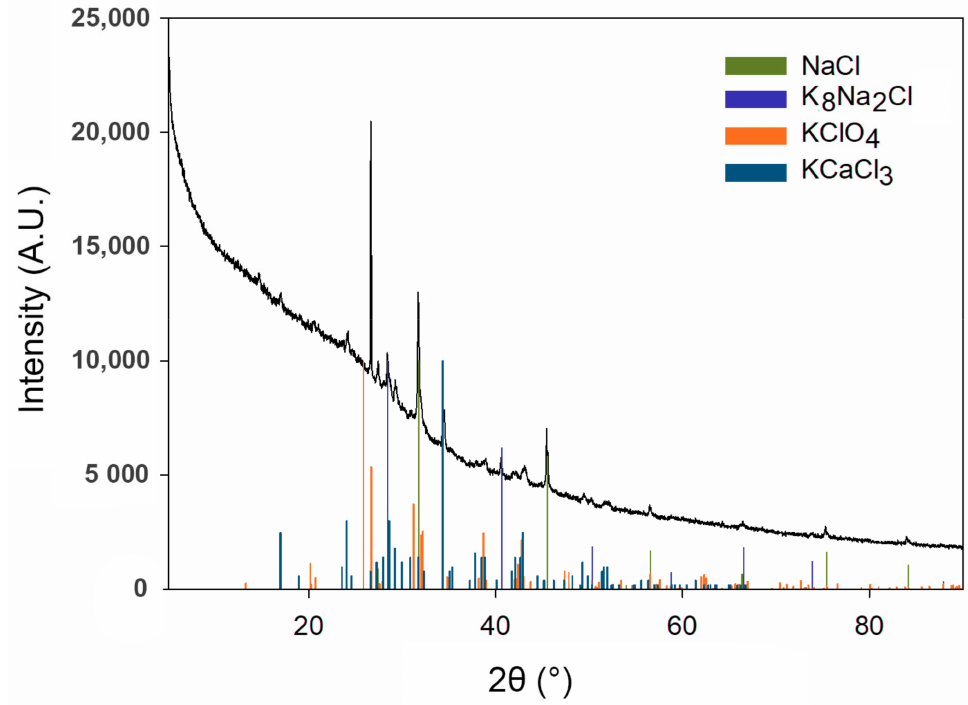
Figure 4. X-ray diffraction patterns of